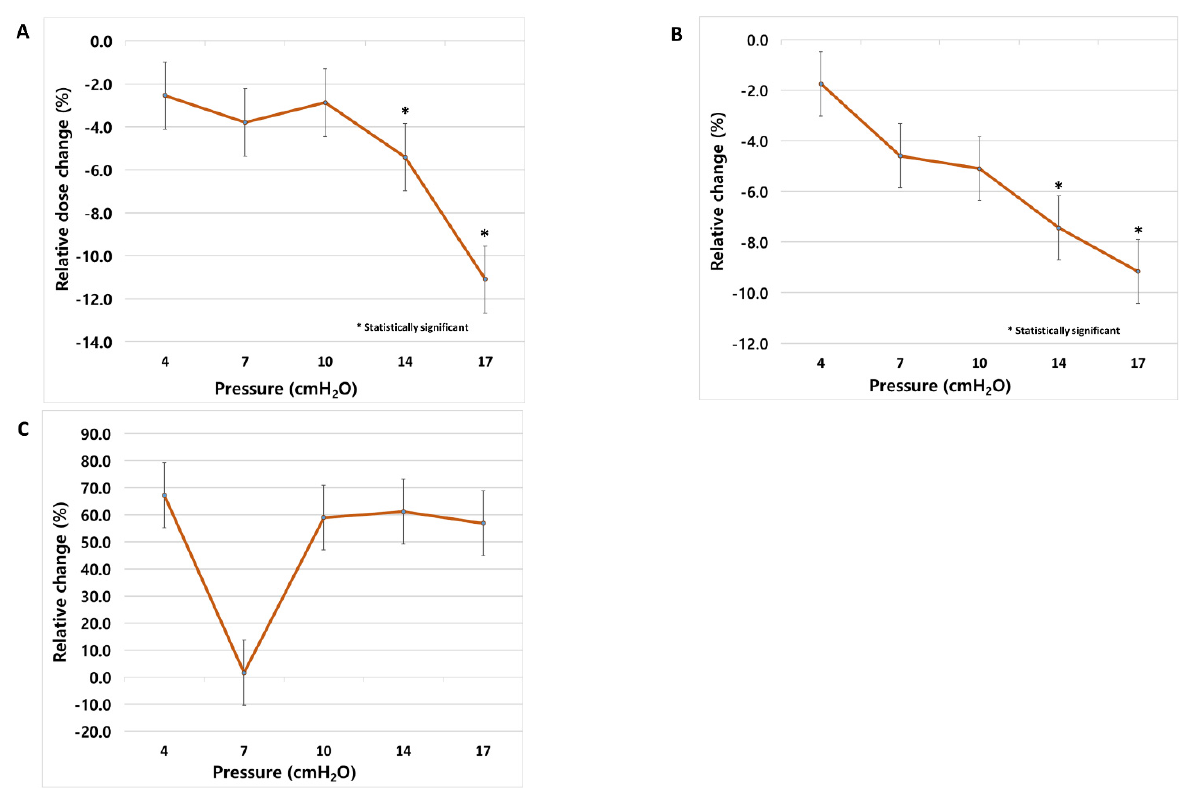
Figure 4. Heart dose parameter change; comparison with baseline; ( A ) D mean , ( B ) V5, and ( C ) V50.